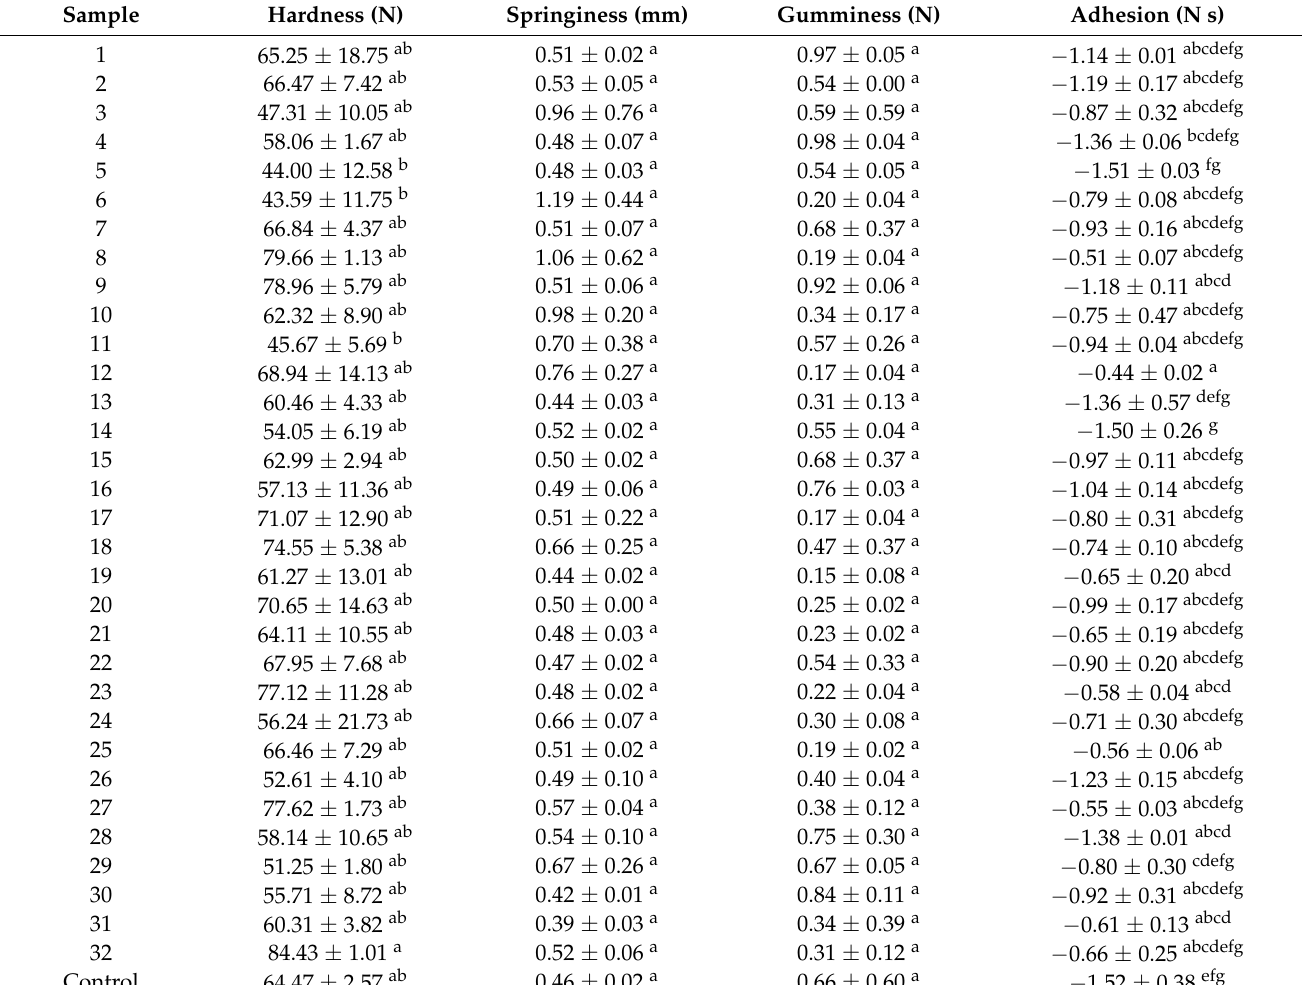
Table 4. Textural properties of sausage core with different modified casing